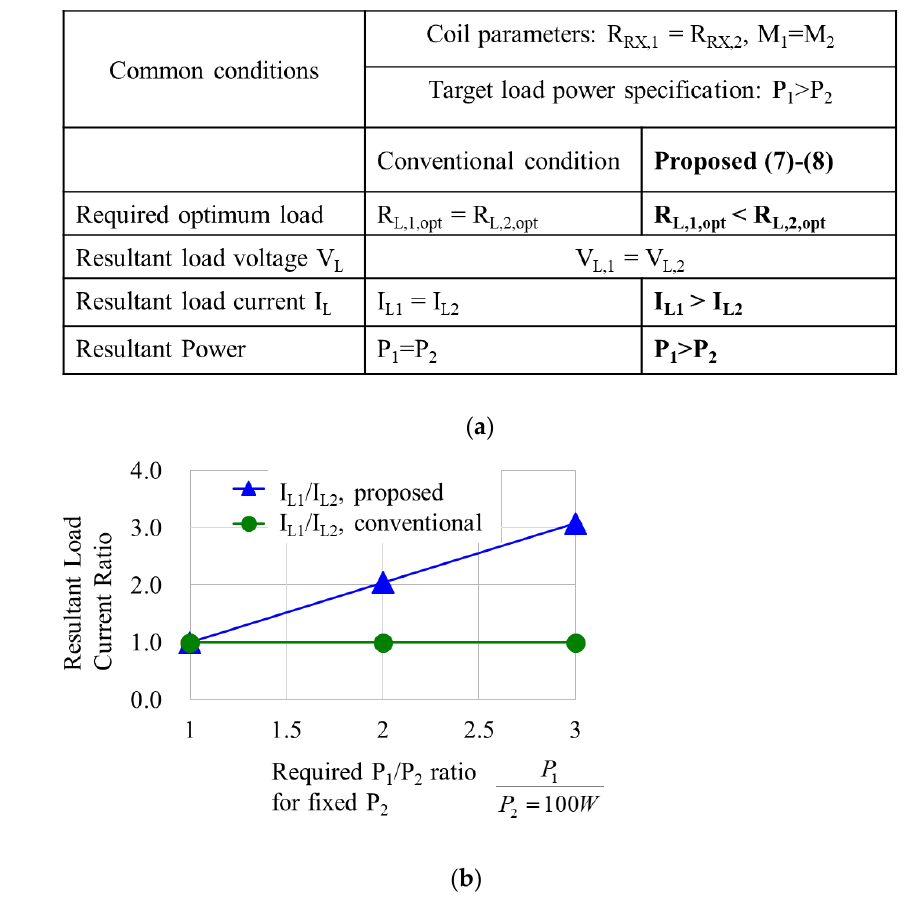
Figure 2. Comparison between conventional condition and proposed condition for maximum efficiency with target power constraints. The proposed method has freedom to choose load current to satisfy the asymmetric power requirement for each receiver. ( a ) Example scenario. ( b ) Resultant load current ratio with respect to the required power ratio.